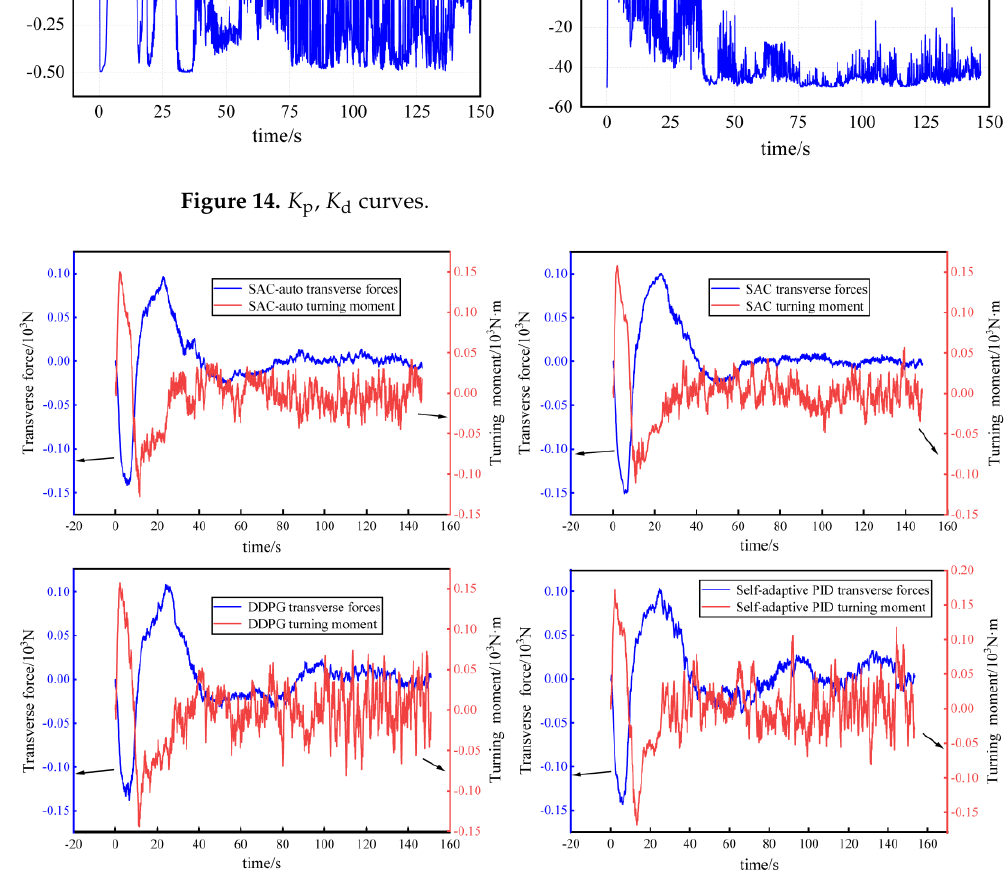
Figure 15. Transverse forces and turning moments.